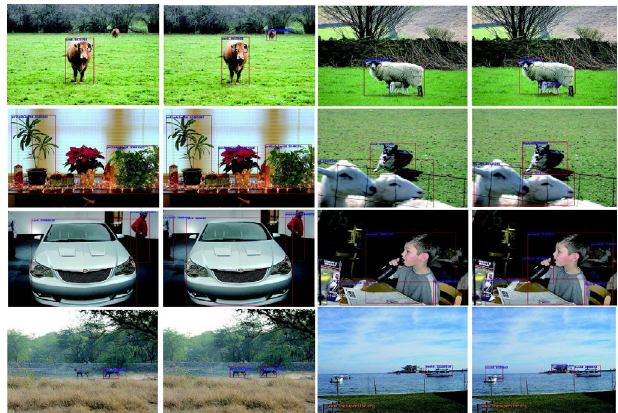
Table 5. Results of CKP-DC and other methods on remote sensing dataset